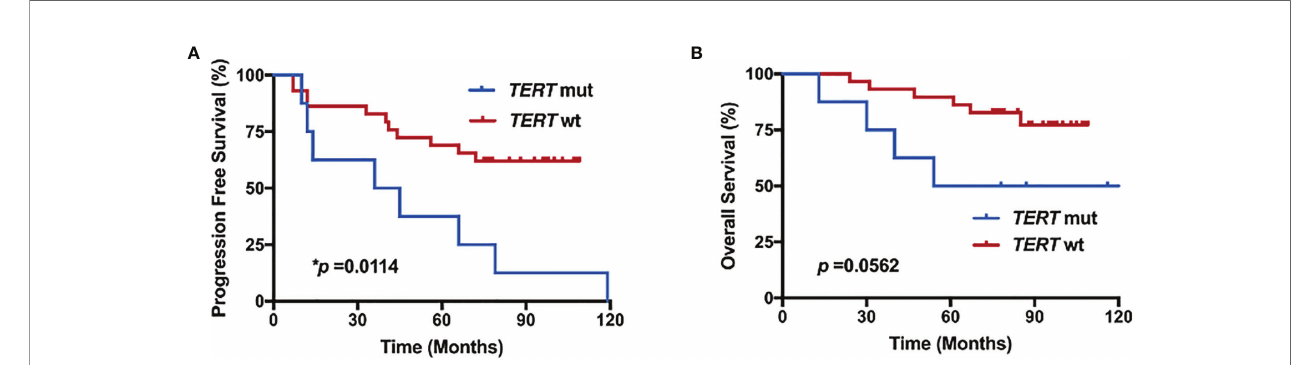
FIGURE 4 | TERT mutations were associated with decreased progression-free survival (PFS) and overall survival (OS) in de novo high-grade meningiomas (HGMs) after radiotherapy (RT). Kaplan – Meier curves for (A) PFS and (B) OS in de novo HGMs with or without TERT mutation following